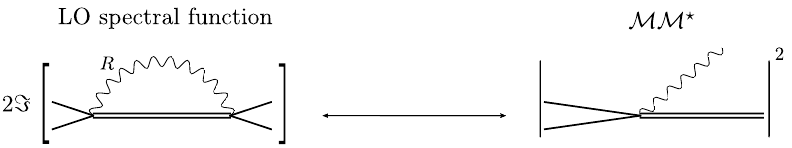
Figure 3 . Correspondence between the leading order self-energy contribution and the amplitude squared shown. R indicates the retarded mediator